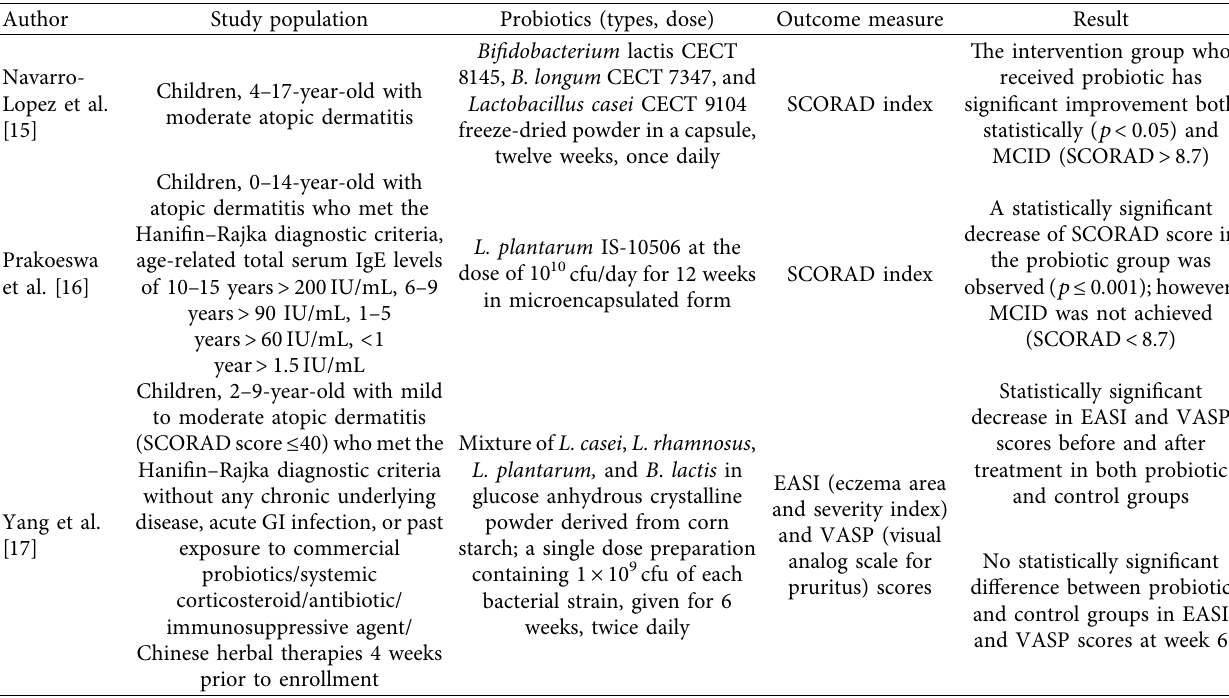
Table 4: Summary of included